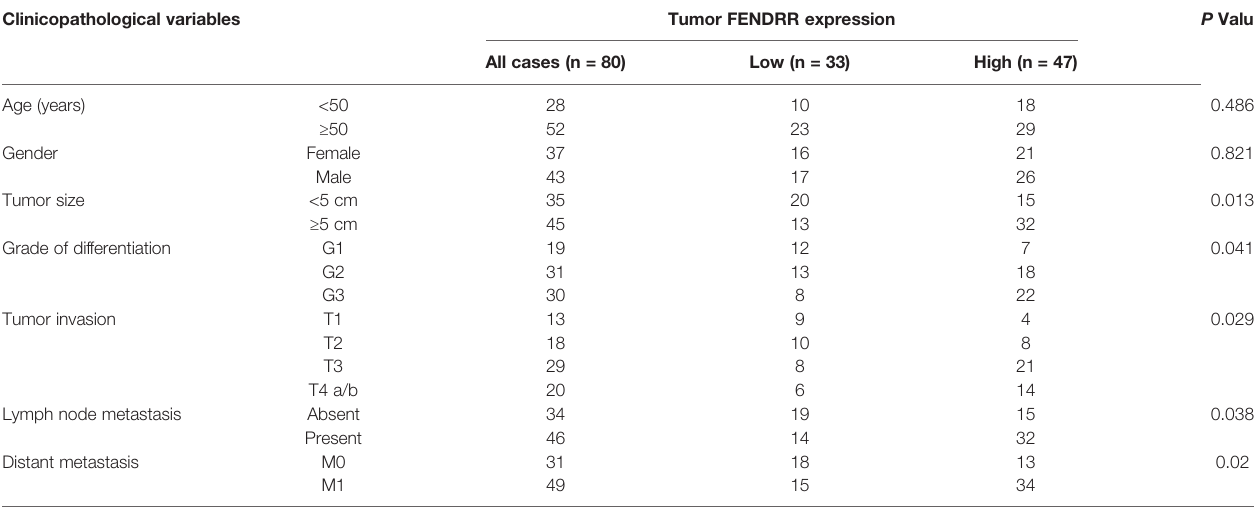
TABLE 1 | Correlation of FENDRR expression and patients ’ clinicopathological variables in GC tissues. Clinicopathological